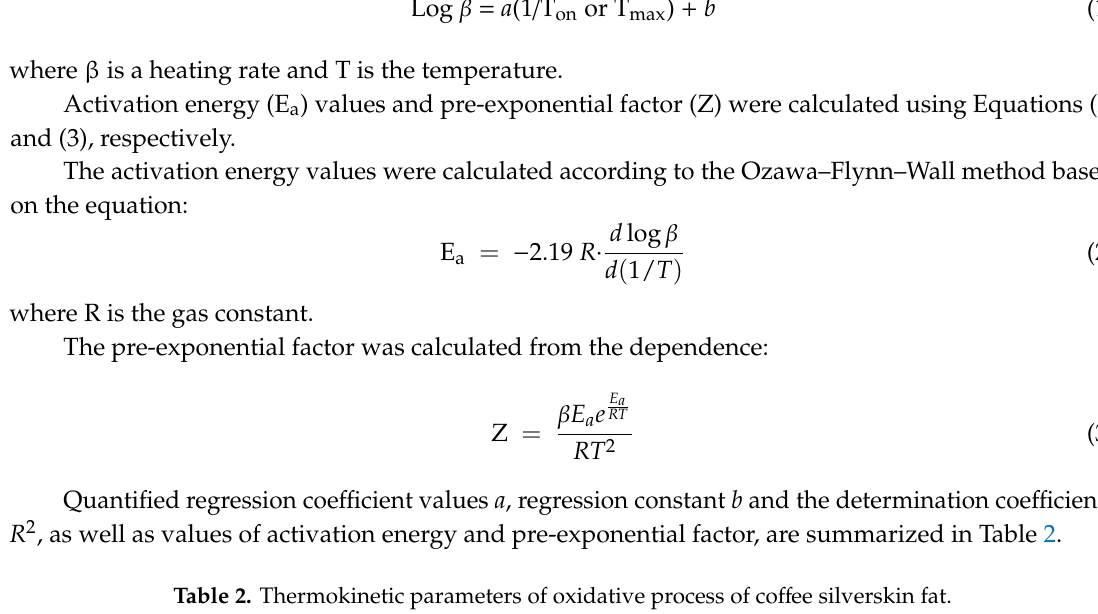
Table 2. Thermokinetic parameters of oxidative process of co ff ee silverskin fat. Parameter Value Calculated for T on Value Calculated for T